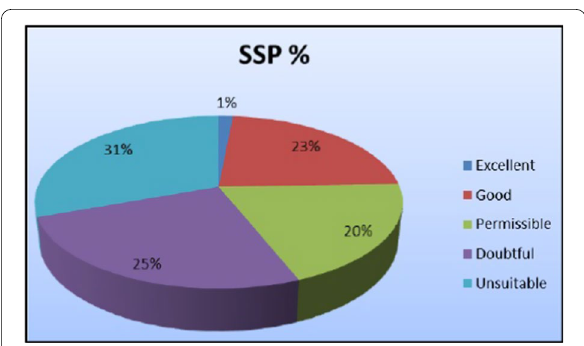
Fig. 14 Groundwater classes according to the percentage of SSP in the available groundwater samples